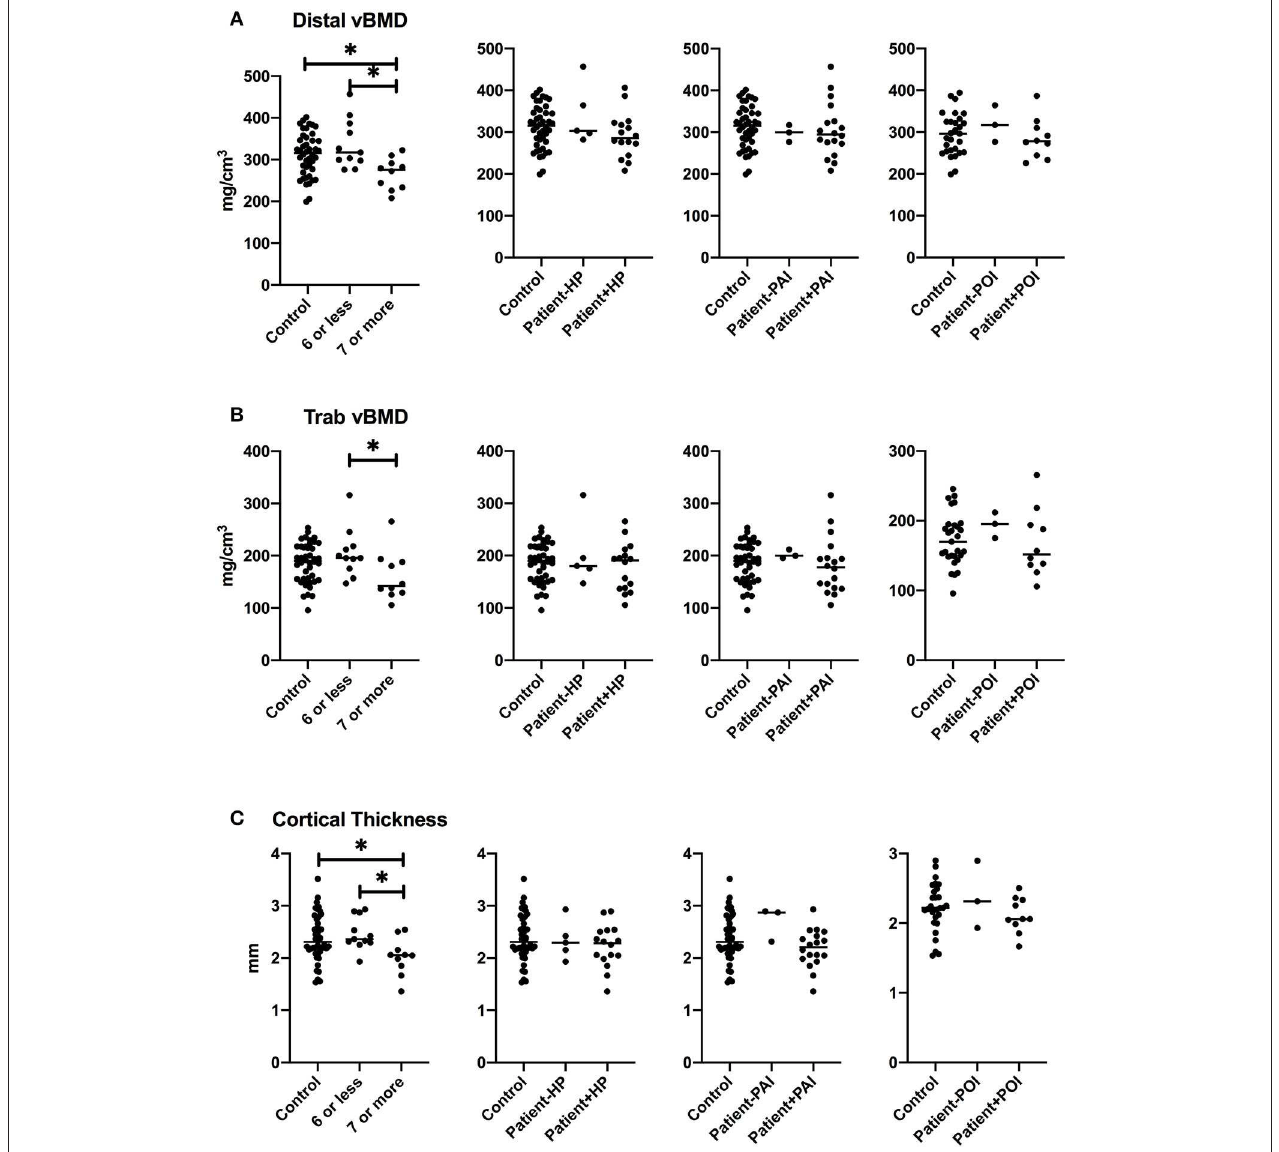
FIGURE 5 | Bone characteristics at radial site in patients older than 40 years with specific manifestation of APECED. Total volumetric bone mineral density at distal site (A) , trabecular volumetric bone mineral density (B) , and cortical thickness (C) in the patients with ≥ 7 disease manifestations, hypoparathyroidism (HP), primary adrenal insufficiency (PAI), or primary adrenal insufficiency (POI) in comparison to other patients and age- and gender-matched control subjects. P values are indicated with asterisk: *, < 0.05.